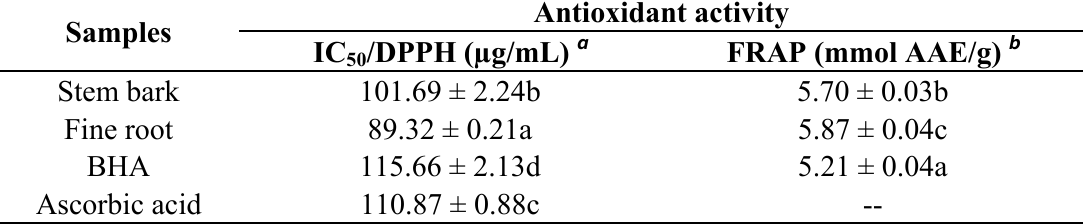
Table 4. Antioxidant activities of the condensed tannins from stem bark and fine root of C. equisetifolia using the (DPPH) free radical-scavenging assay and the (FRAP) ferric- reducing antioxidant power assay (n =